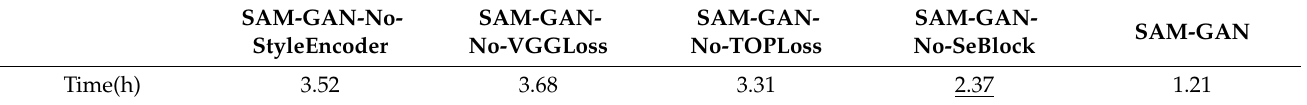
Table 7. Quantitative assessment scores for SAM-GAN ablation experiments, where δ is taken as 1. (Bold: performance first; underlined: performance